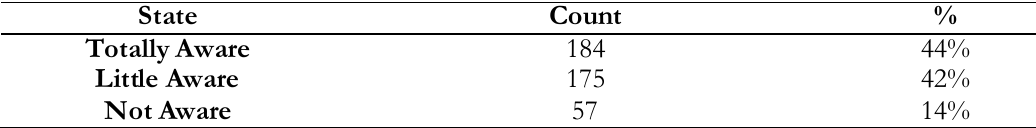
Table: 4: Awareness of consequences of non-adherence in Aseer